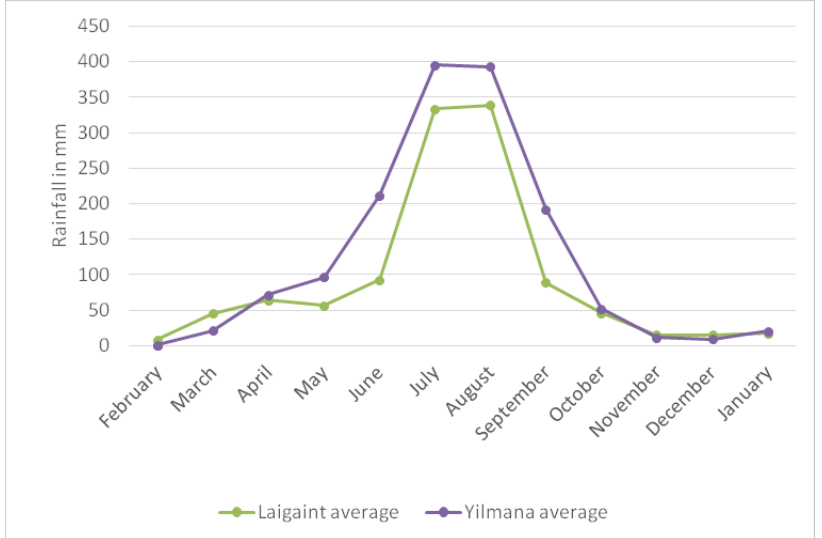
Figure 2: Mean rainfall distribution at Laigaint and Yilmana, in two major potato production seasons (Belmehr and